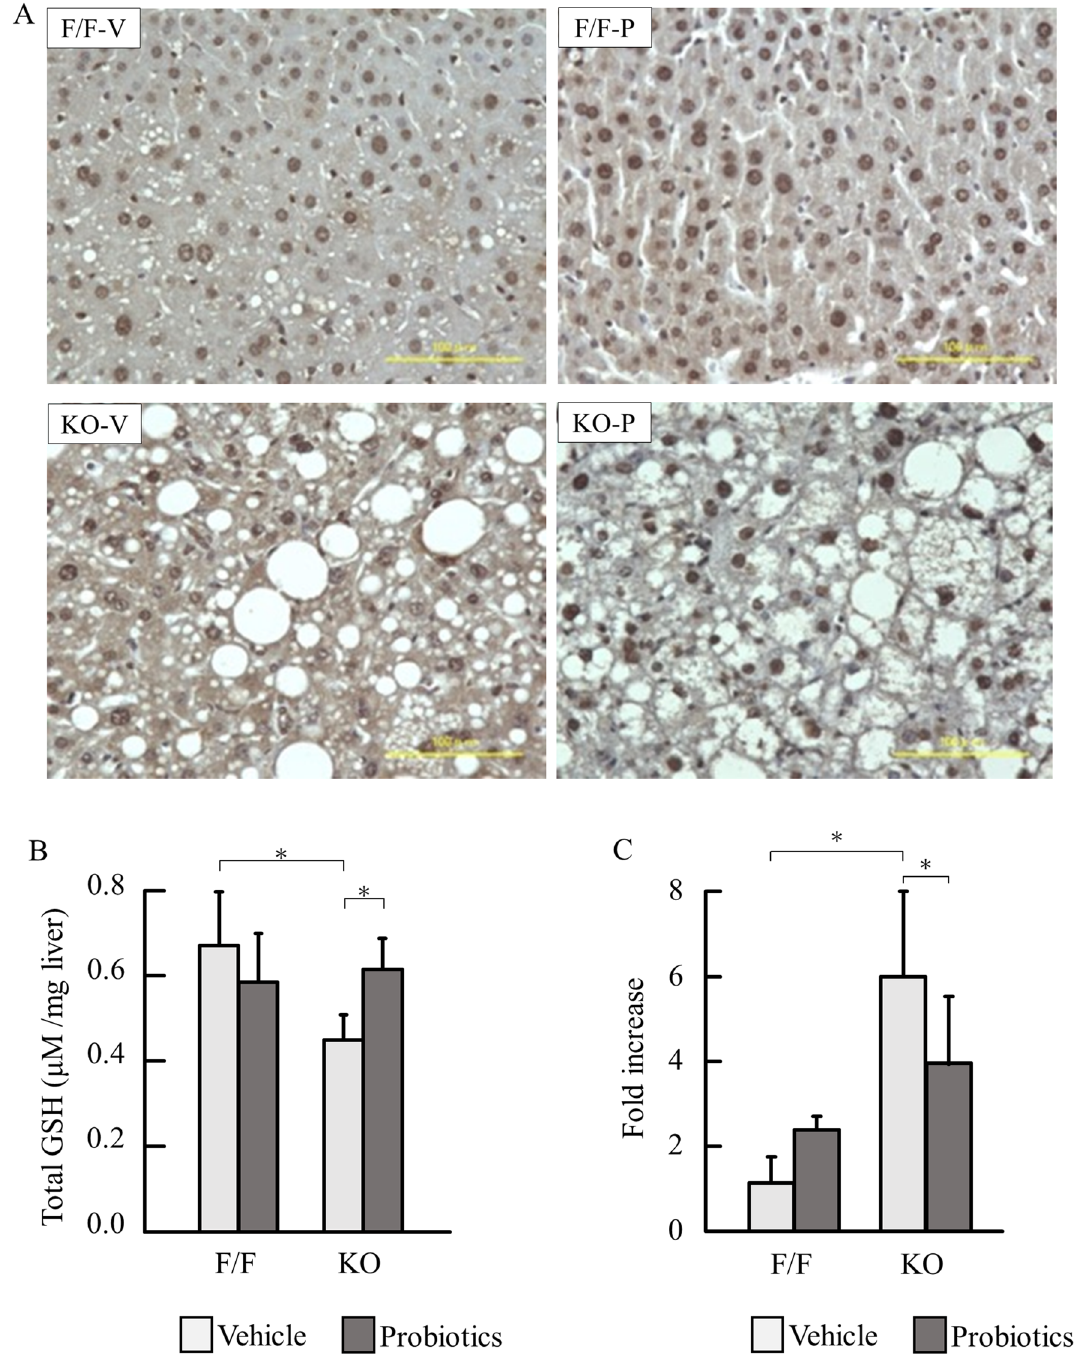
were performed in technically